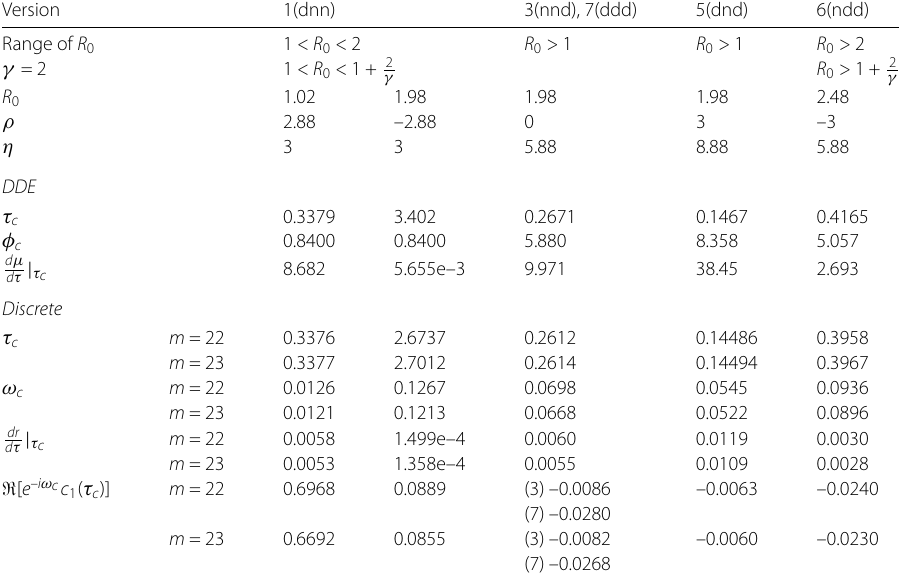
Table 12 Critical bifurcation values for endemic equilibrium of the ELM models Version Range of R